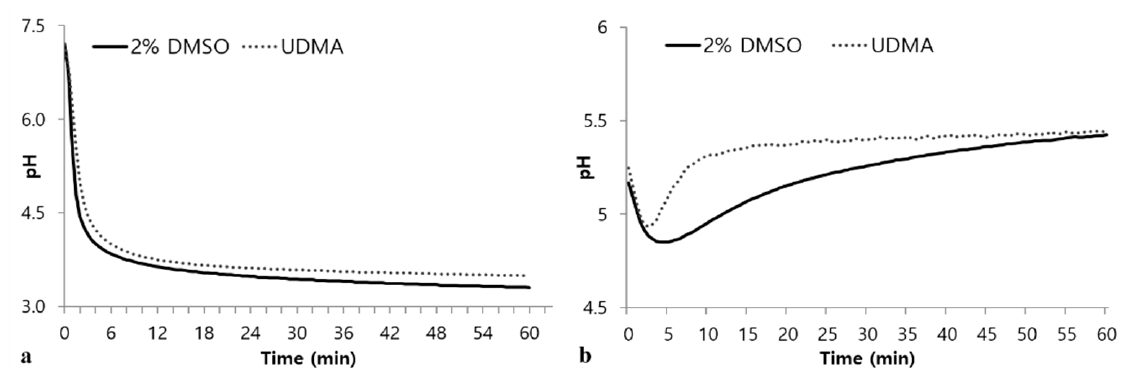
Figure 8. Glycolytic pH profiles of S. mutans UA159 grown in a medium with and without UDMA in the presence of excess glucose ( a ), or from endogenous stores ( b ). DMSO was used as a vehicle for UDMA, and cells grown in the absence of UDMA (2% DMSO) were used as the control.